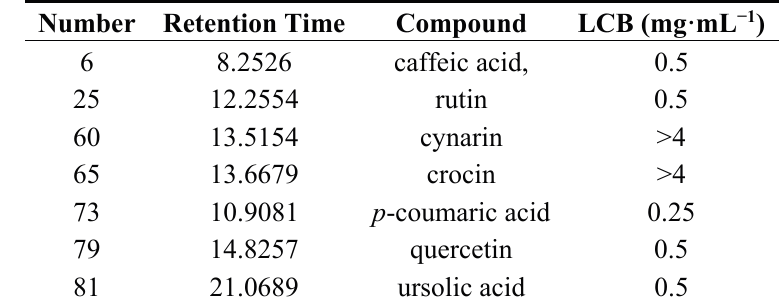
Table 2. Biofilm inhibition activity of the compounds identified among the potential anti-biofilm